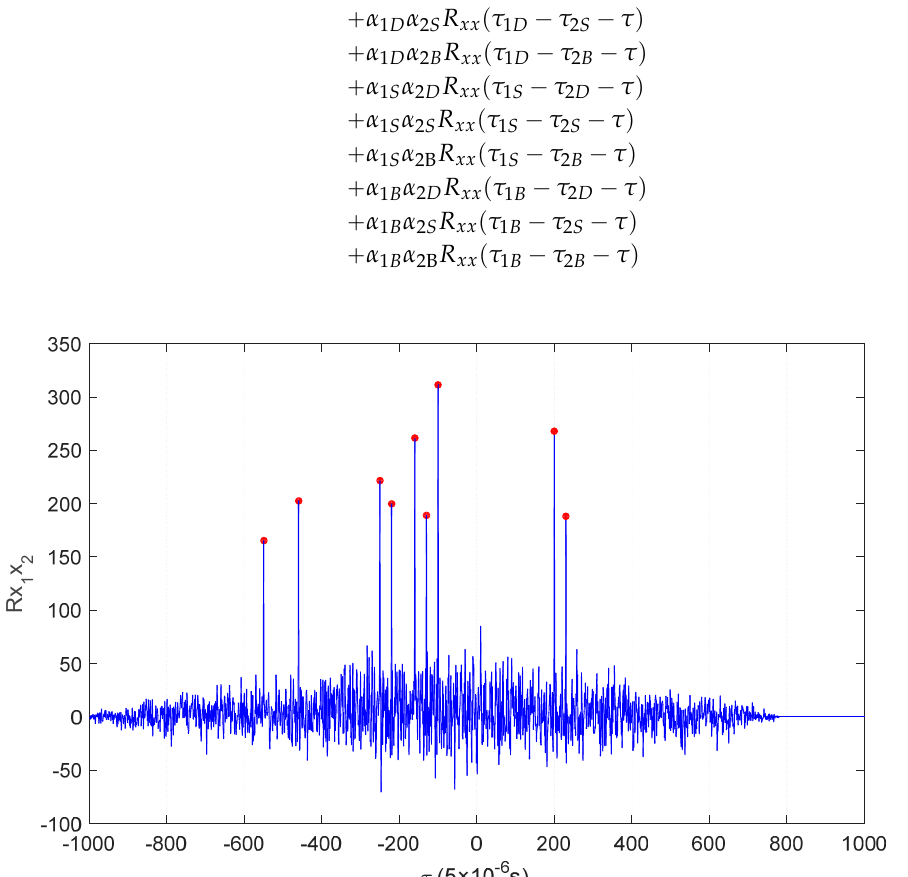
Figure 6. Ambiguity phenomenon of correlation peaks.